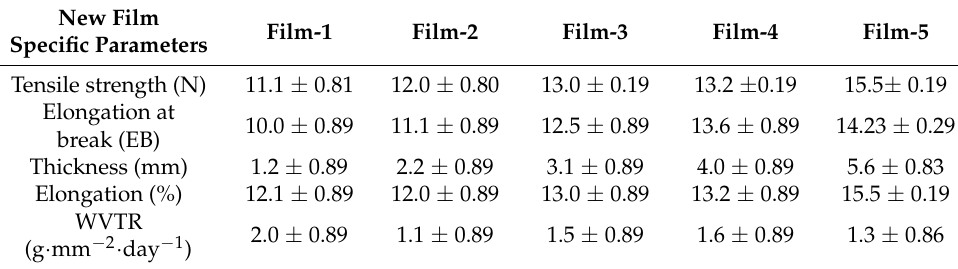
Table 2. Mechanical properties of the new